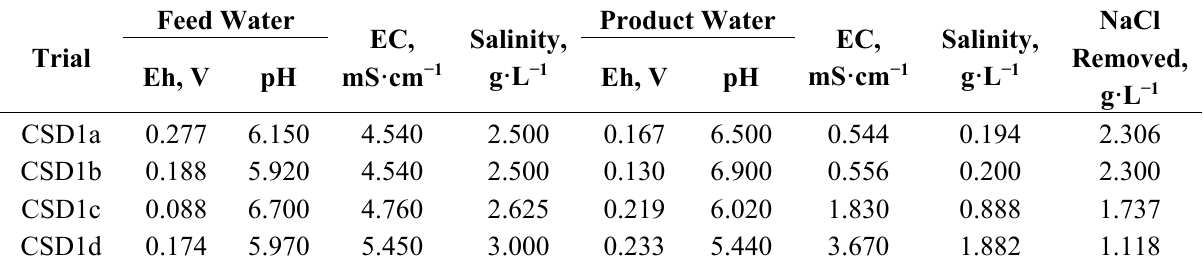
Table 5. Feed and product water compositions: CSD